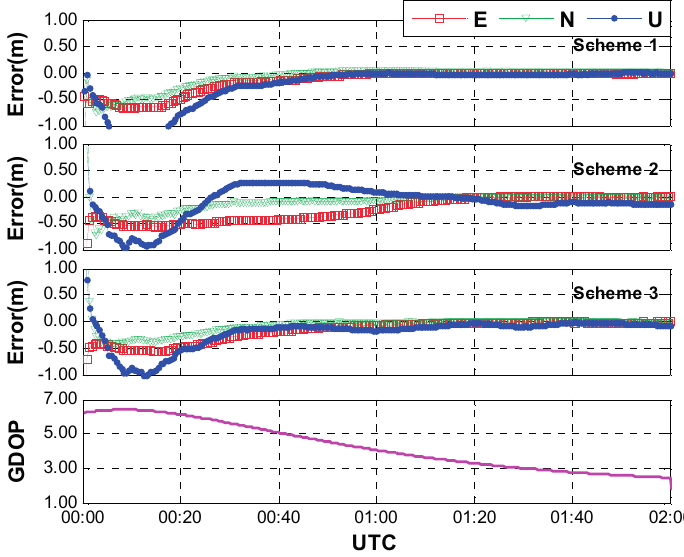
Figure 9. Positioning error and GDOP of GPS/GLONASS combined PPP with different ISB models (case two: limited number of GPS and GLONASS satellites, an average of 6 satellites